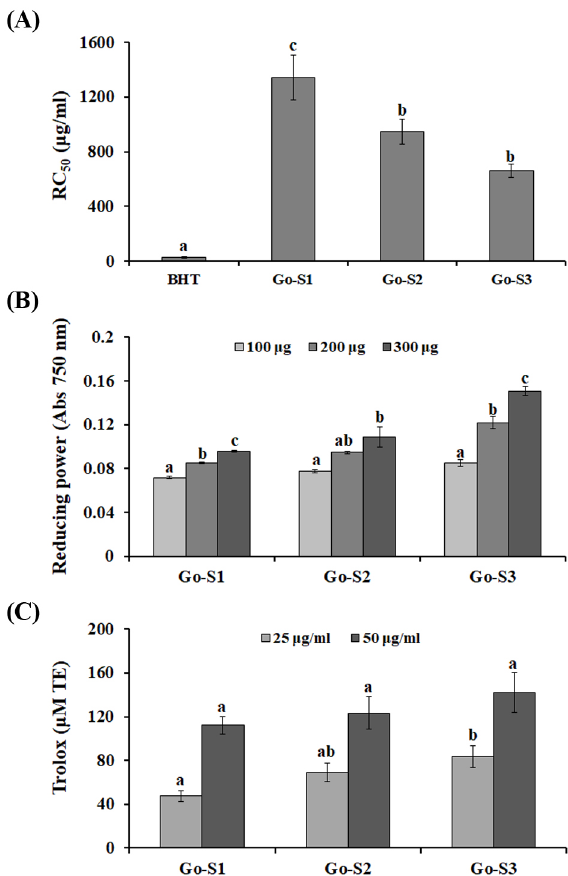
Fig. 2: Antioxidant activities of Panax ginseng berry extracts were measured by DPPH free radical scavenging (A) , reducing power (B) and ORAC (C) assays. DPPH radical scavenging activity was calculated as RC 50 . ORAC values of each organ extract are expressed as μmol of Trolox equivalents per g dry weight. Bars represent the mean ± S.E. of three independent experiments. Different letters in each column represent significant differences between the ripening stages ( p < 0.05).